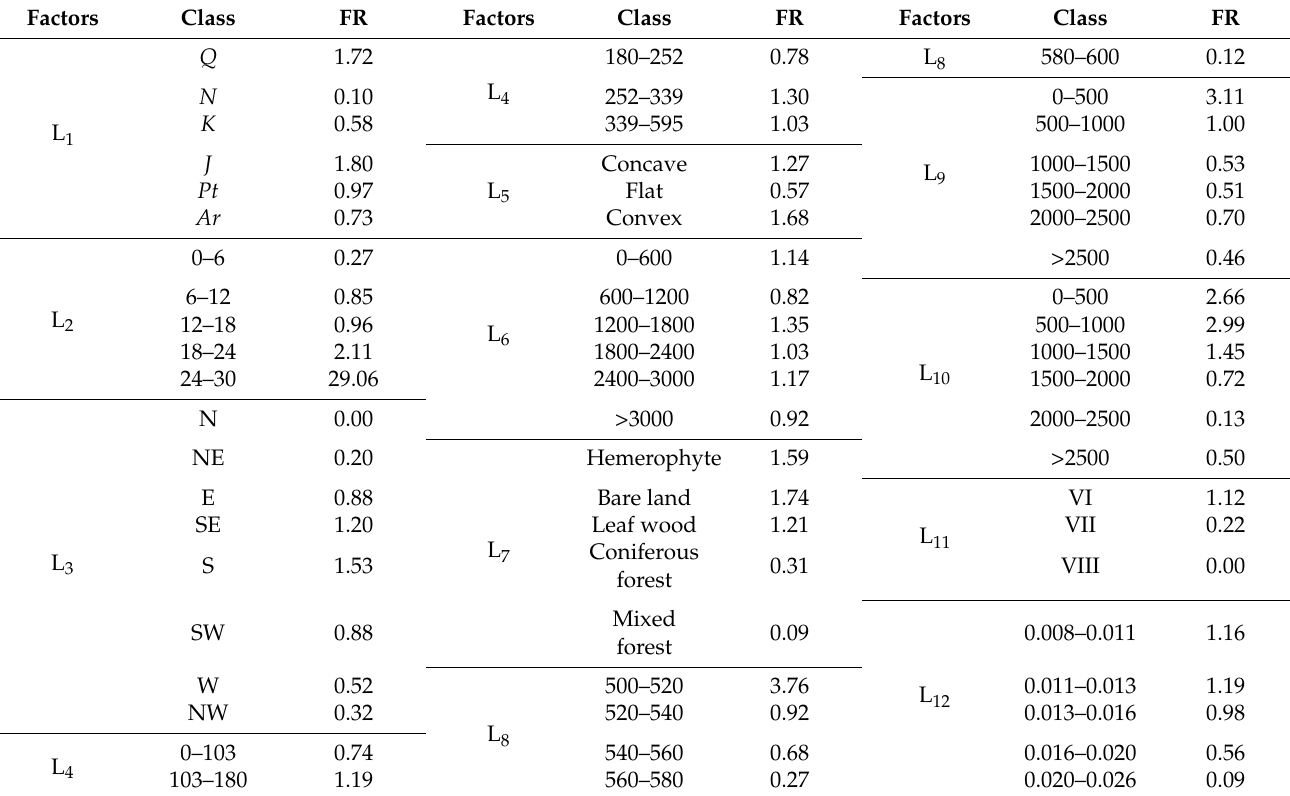
Figure 6. Importance of landslide conditioning factors to the SVM and ANN models. Table 6. Statistics of FR values of each subclass of the landslide conditioning factors.